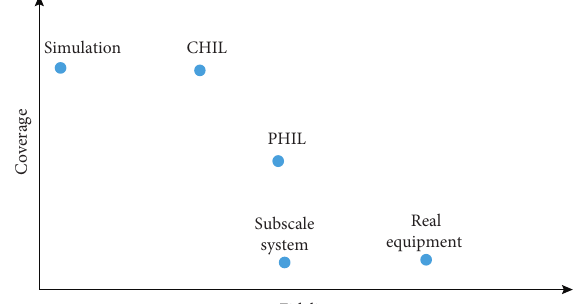
Figure 2: The coverage and fidelity of the different testing methods. Adapted from